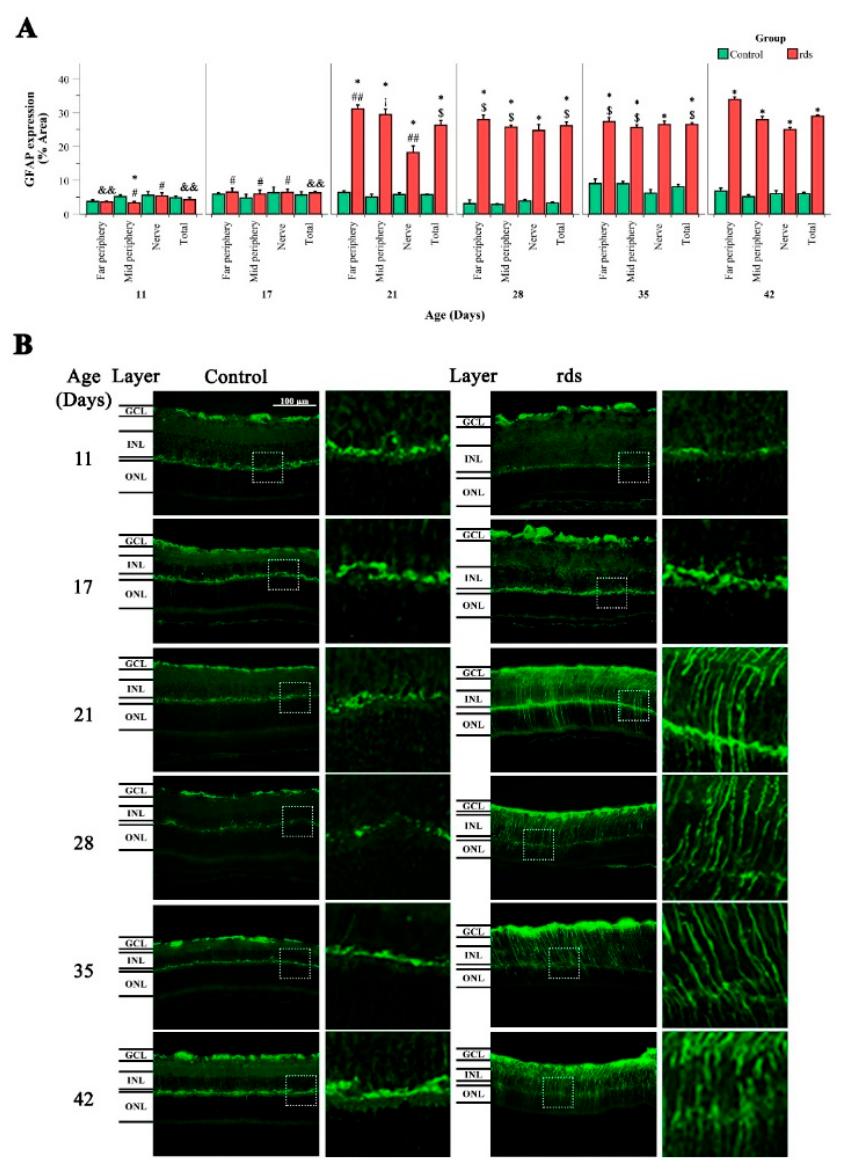
Figure 8. GFAP retinal immunostaining. ( A ) Histogram comparing GFAP (% stained area) in control and rds retinas at PN11, PN17, PN21, PN28, PN35, and PN42 in far periphery, midperiphery, near the nerve, and total retina. Values are represented as mean density ± SEM for at least 4 mice/group (* p < 0.0001 vs. control at the same postnatal age; # p < 0.005 vs. rds PN21, PN28, PN35, and PN42; ## p < 0.005 vs. rds PN28, PN35, and PN42; && p < 0.01 vs. rds PN17, PN21, PN28, PN35, and PN42,